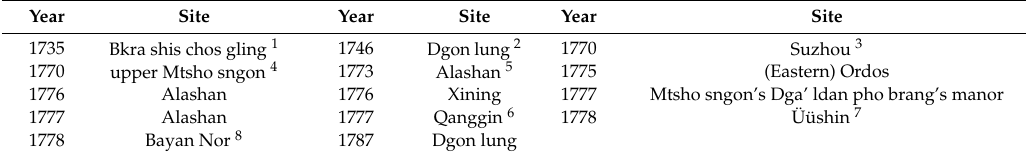
Table 1. Sumpa Khenpo’s sites for his rainmaking